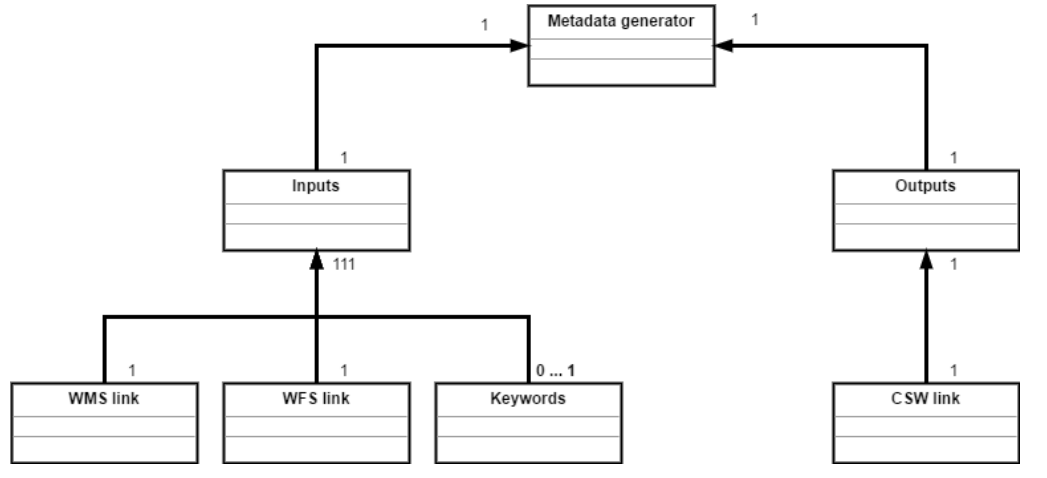
Figure 8. UML with input and output parameters metadata